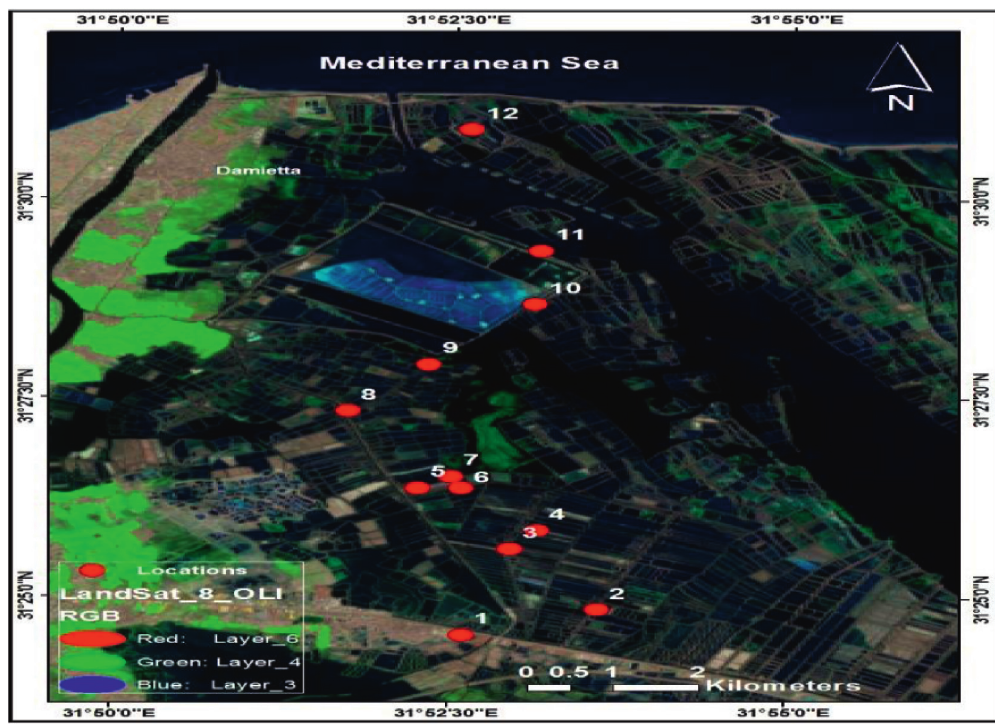
Figure 1: Sampling sites from Lake Manzala,